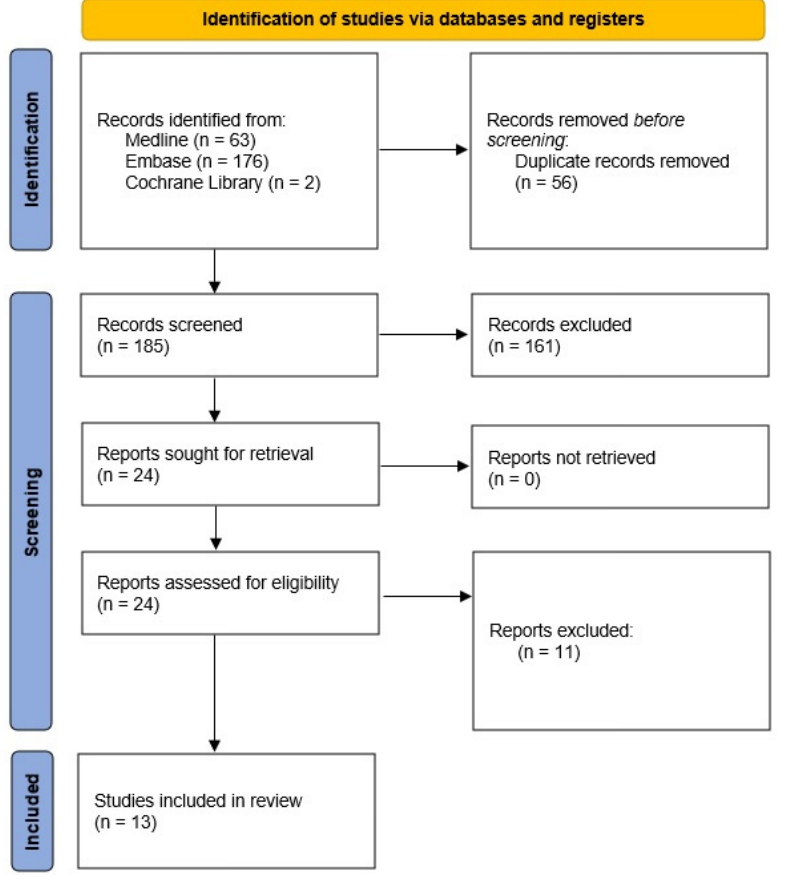
Figure 1. PRISMA flow diagram.